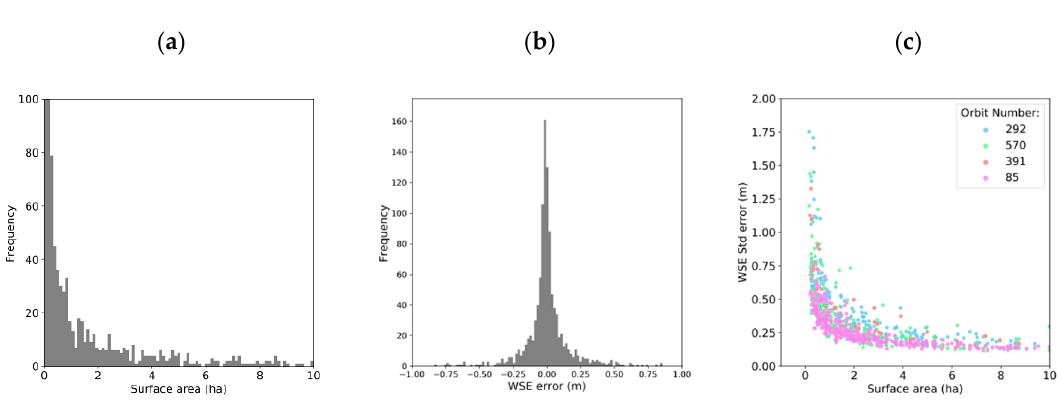
Figure 3. ( a ) Gravel pits size distribution; ( b ) Water Surface Elevation (WSE) errors simulated for 801 gravel pits of La Bassée on a five-year period; ( c ) standard deviation of the simulated SWOT-like WSE errors according to the surface area and for the four orbits sampling the 801 gravel pits studied.